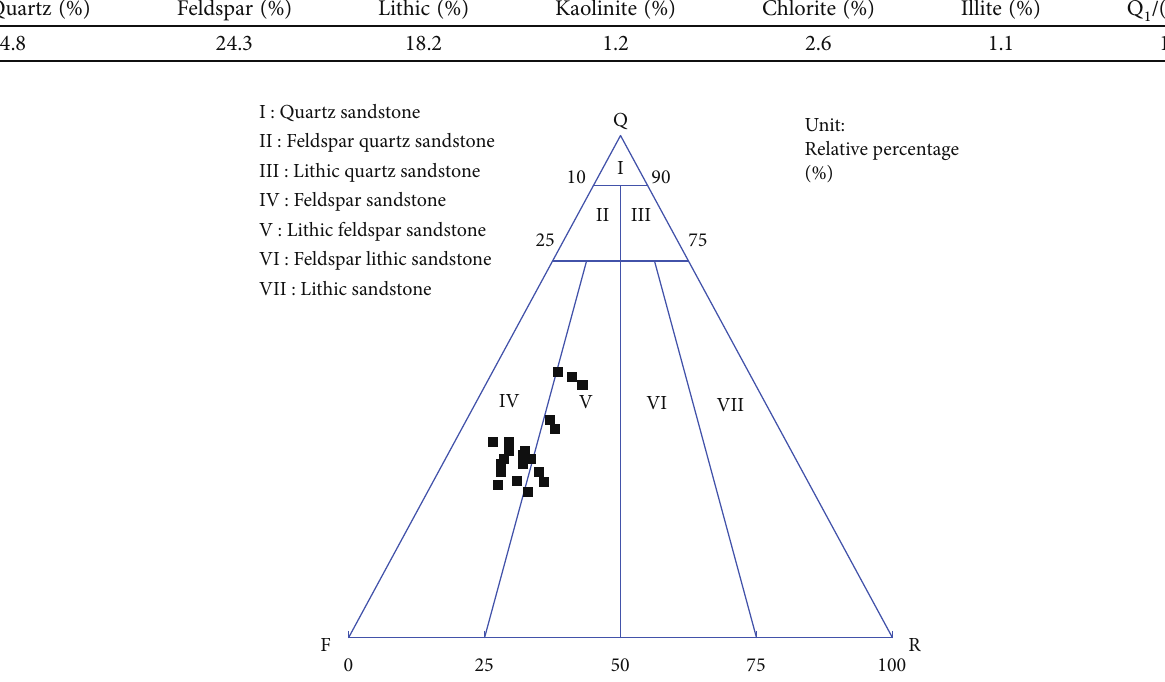
Figure 2: Triangulation of the Chang 6